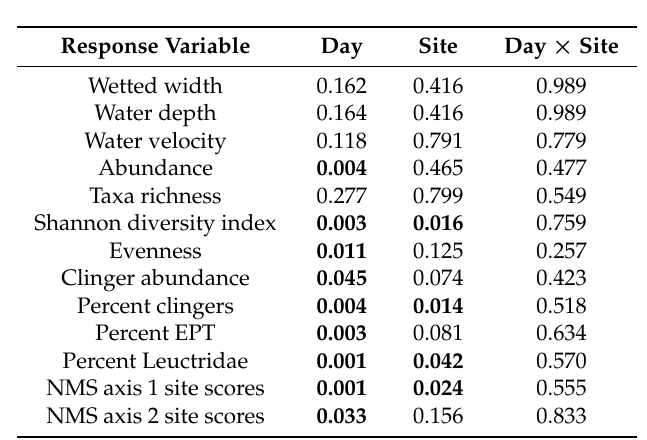
Table 2. p -values from linear mixed effect model analysis of the effect of sampling day, site and the interaction effect of day and site on hydrologic and aquatic macroinvertebrate community response variables within three agricultural headwater streams of the upper Alum Creek, OH, USA from 5 to 14 June 2015. Bolded p -values are those that were significant ( p < 0.05). Abbreviations